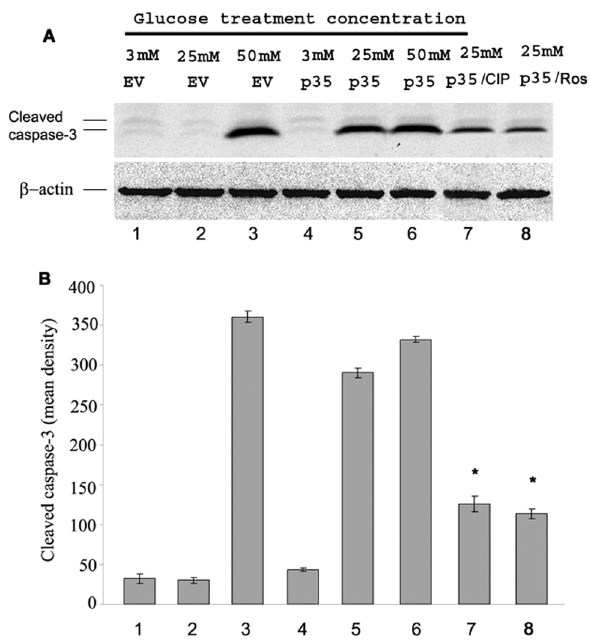
Figure 6. CIP can rescued high glucose treatment induced apoptosis in overexpressed p35 Min6 cells. A Cells infected with p35 were apoptotic at both 25 mM and 50 mM glucose concentrations (lanes 5 and 6). Cells with co-transfected CIP however, showed a reduced level of apoptosis (lane 7), and the same result can be see in the cells treated with roscovitine (lane 8). The control cells at HG (50 mM) showed a strong cleaved caspase 3 band which indicated that very high glucose is indeed cytotoxic. Interestingly, there is no apoptosis markers in the cells infected with p35 and treated with 3 mM glucose (lane 4). B The apoptosis data quantified from A, (* P , 0.01). Data represent mean 6 SE of three experiments.